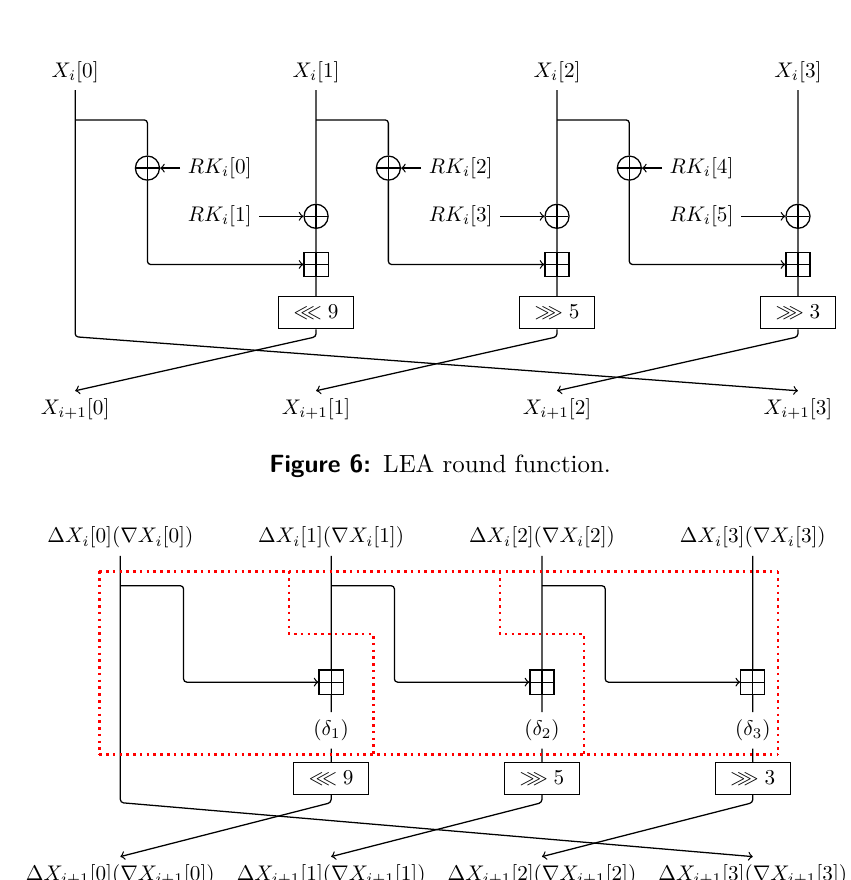
Figure 7: A 1-round switch of LEA. (The symbols for the backward direction are given in the